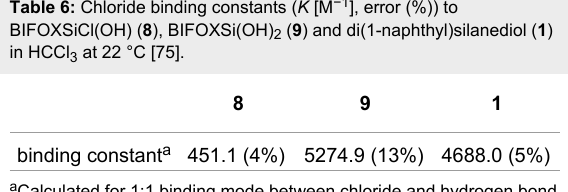
Table 6: Chloride binding constants ( K [M − 1 ], error (%)) to BIFOXSiCl(OH) ( 8 ), BIFOXSi(OH) 2 ( 9 ) and di(1-naphthyl)silanediol ( 1 ) in HCCl 3 at 22 °C [75]. 8 9 1